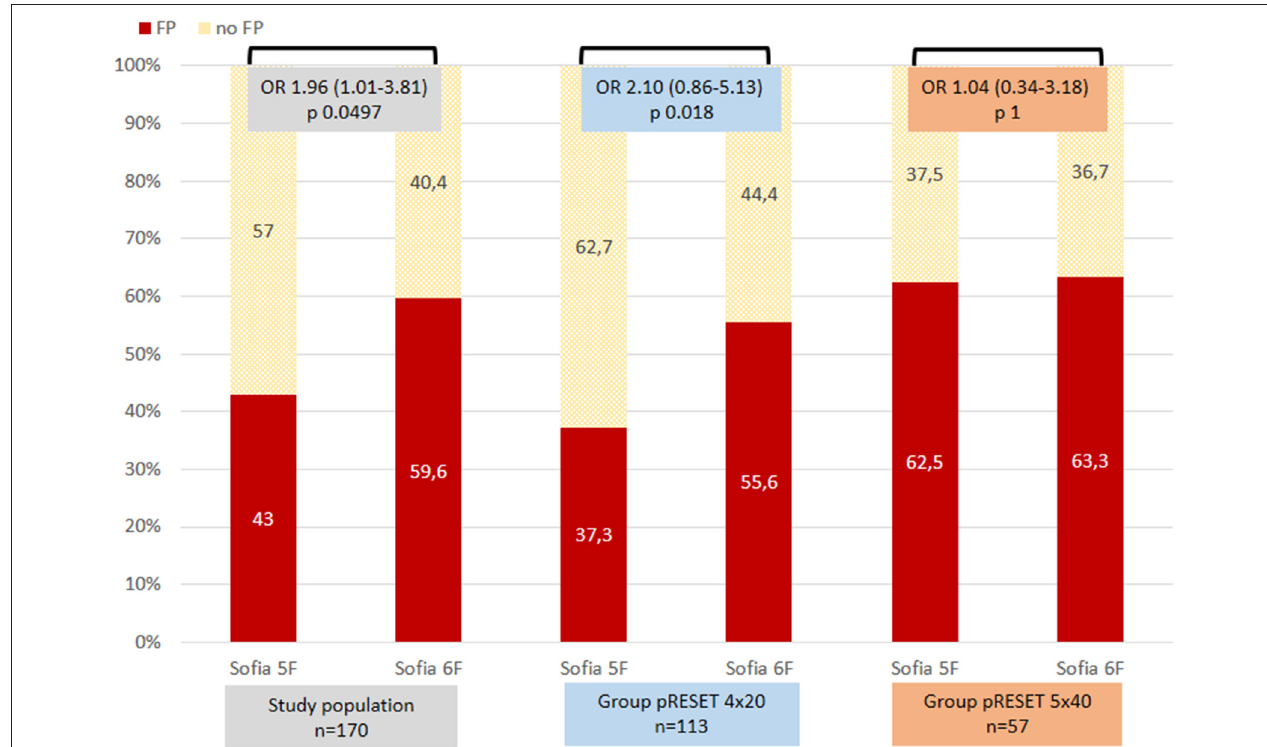
FIGURE 2 | First-pass reperfusion (FP) regarding use of distal access catheter in the whole population and in groups 4 × 20 and 5 × 40. Statistics, Fisher exact test; odds ratio (OR) and 95% confidence interval (CI).